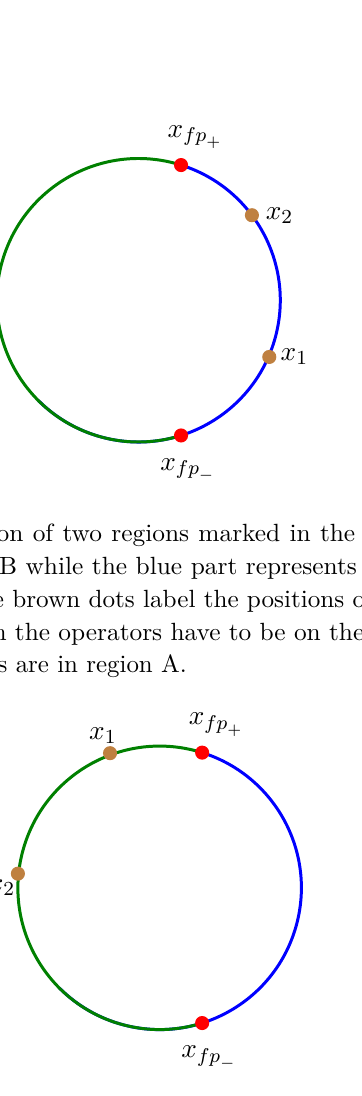
Figure 4 . Same as figure 3 but with both points in region B. This corresponds to the shaded center square of figure